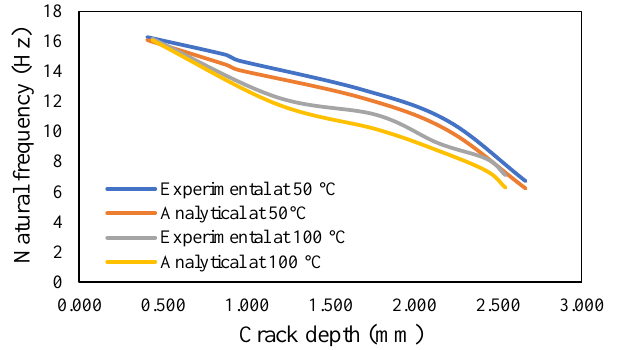
Figure 32. Comparison of the natural frequency of the propagated crack at an isothermal temperature of 50 and 100 °C.